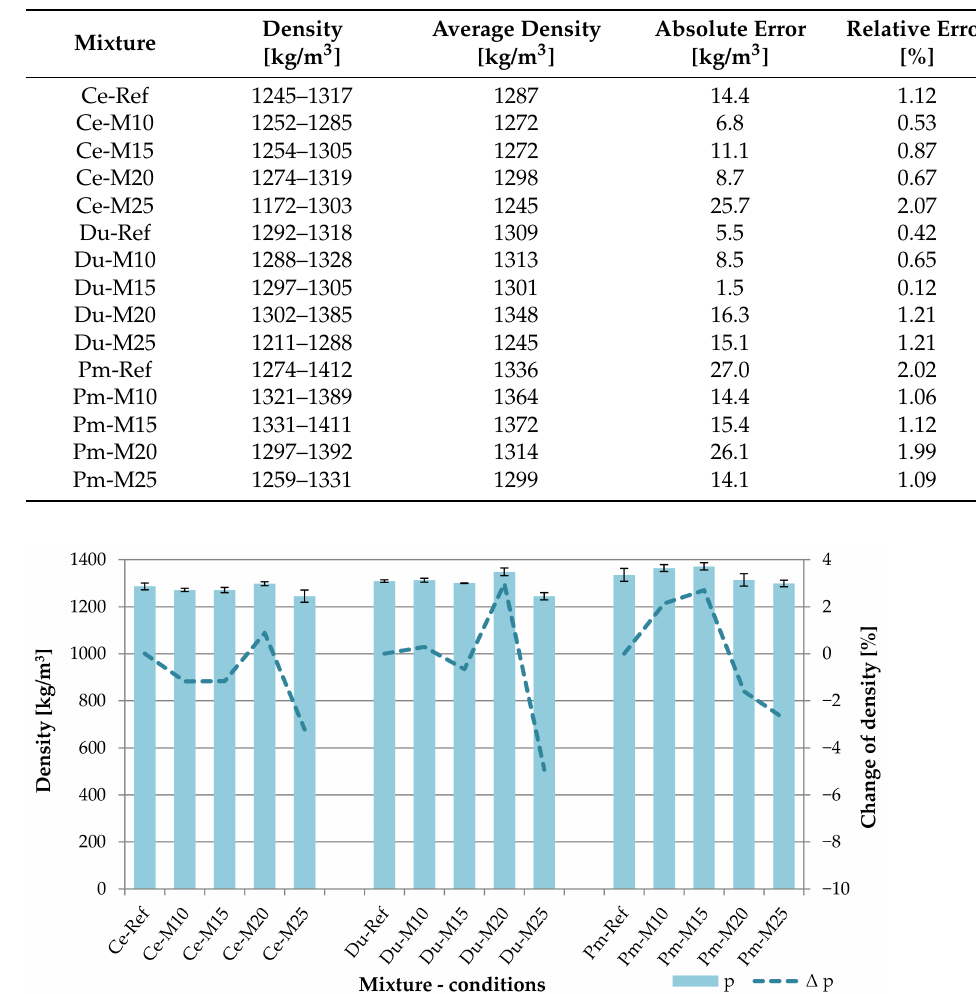
Table 3. Results of density testing of modified cement-bonded particleboards.